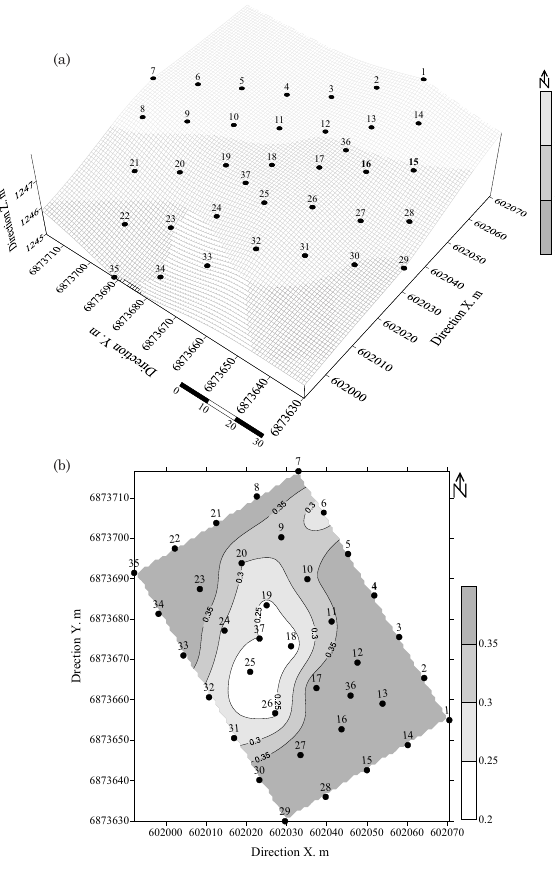
Figure 1. Planialtimetric map of the experimental area, represented by the altitude above sea level with 37 collection points in the area (a) and sketch of the effective soil depth (contours in m) determined at each respective sample point (b). At each point of observation the point number is